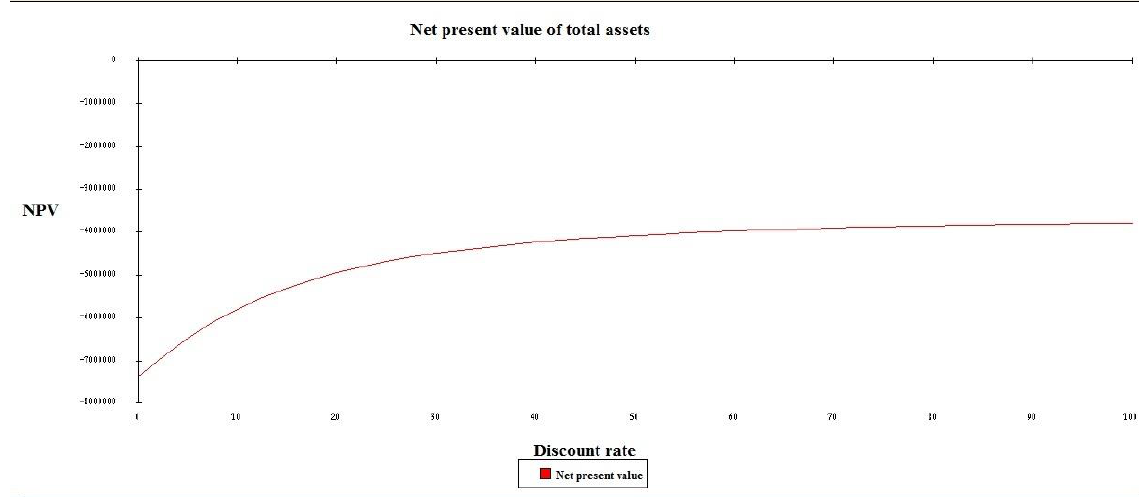
Figure 1. Total Capital NPV (per one-tenth